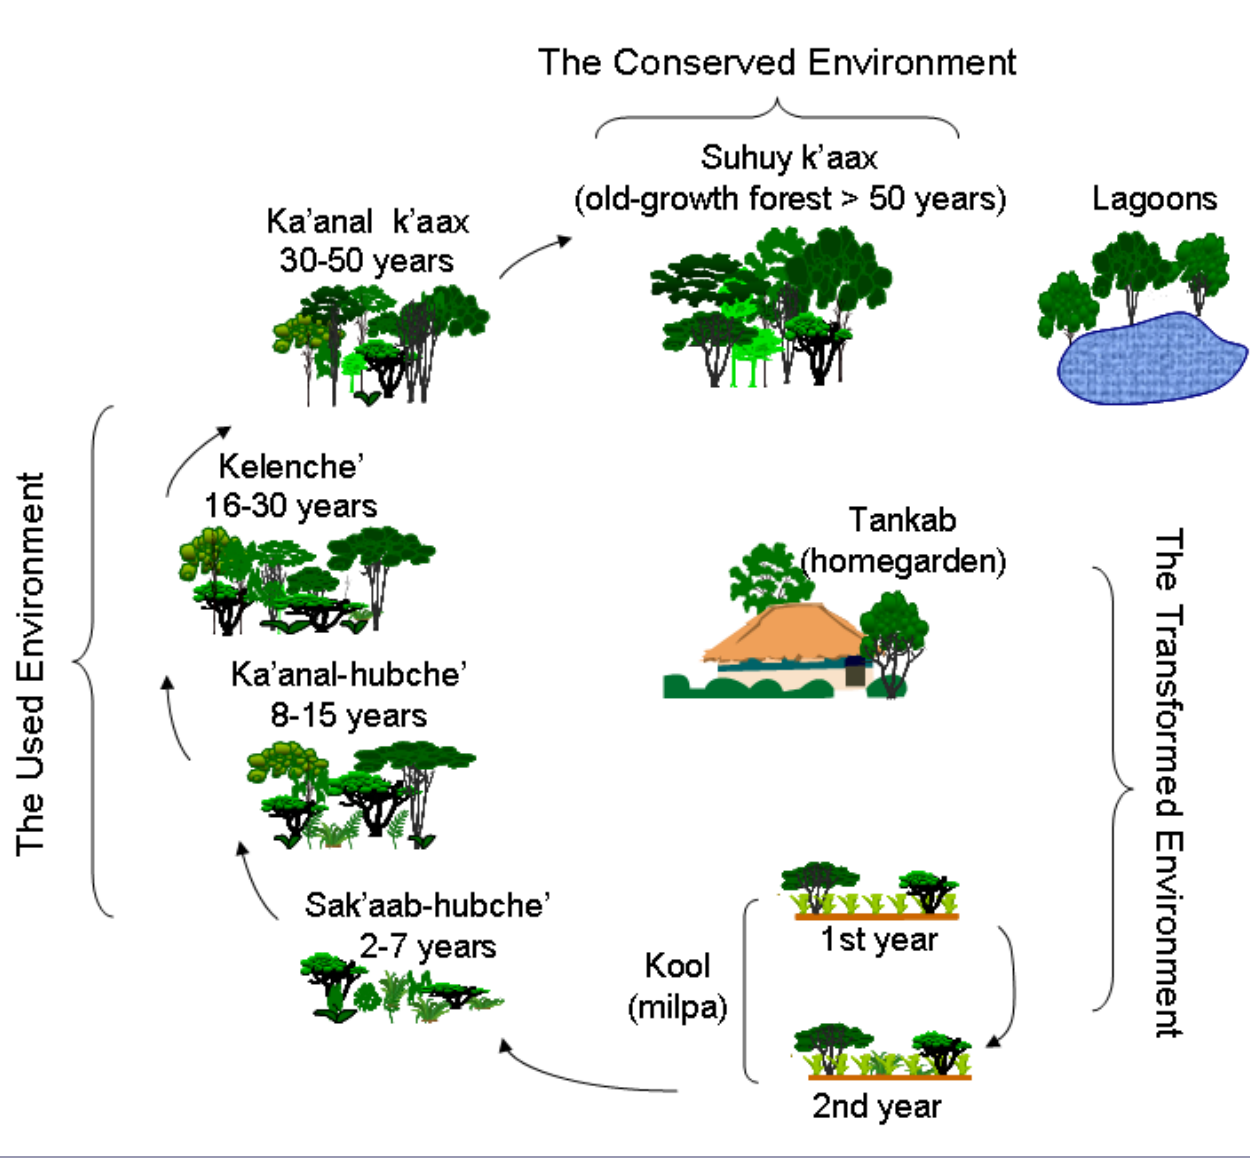
Fig. 3. The Yucatec Maya multiple-use natural resource management